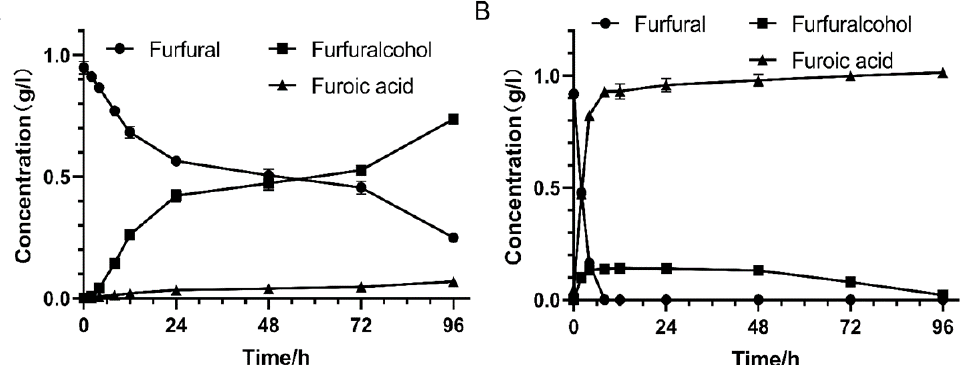
Figure 7. Degradation of furfural by recombinant E. coli with W826-RS0111485 . ( A ) is the control group, and E. coli contains empty pET-28a(+) plasmid. ( B ) is the experimental group, and E. coli contains pET28a(+)- W826-RS0111485 recombinant plasmid. E. coli containing empty plasmid pET- 28a(+) and recombinant plasmid pET-28a(+)- W826-RS0111485 were induced overnight, centrifuged at 7000 g for 10 min, and resuspended in 0.02 M, pH 7.4 phosphate buffer. The furfural was added to the final concentration of 1 g/L, and the cell concentration was set to 1 × 10 9 , that is, the OD600nm was about 1.0. The cells were shaken at 37 °C and 220 rpm. Samples were taken at regular intervals and centrifuged at 12,000 rpm for 10 min, and the supernatant was used to detect inhibitor degra- dation.